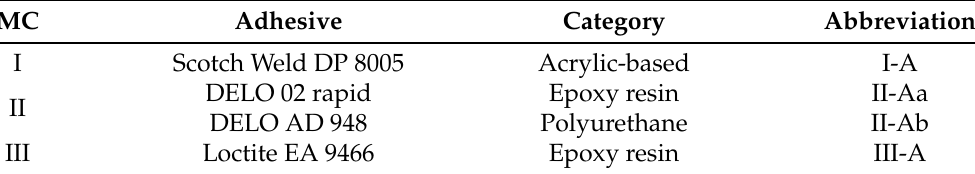
Table 3. Overview of the material combinations, the used adhesive (A) and their abbreviation used in this